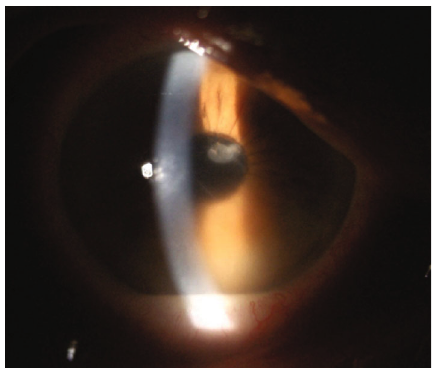
Figure 1: Slit-lamp photograph showing an edematous cornea with Descemet ’ s membrane wrinkles; in the anterior chamber many small cells and a 2 mm hypopyon were found. A big fi brin fl ake near the IOL was well-revealed. Table 1: Included studies comprehensive of cases of endophthalmitis with silicone oil endotamponade. Type of